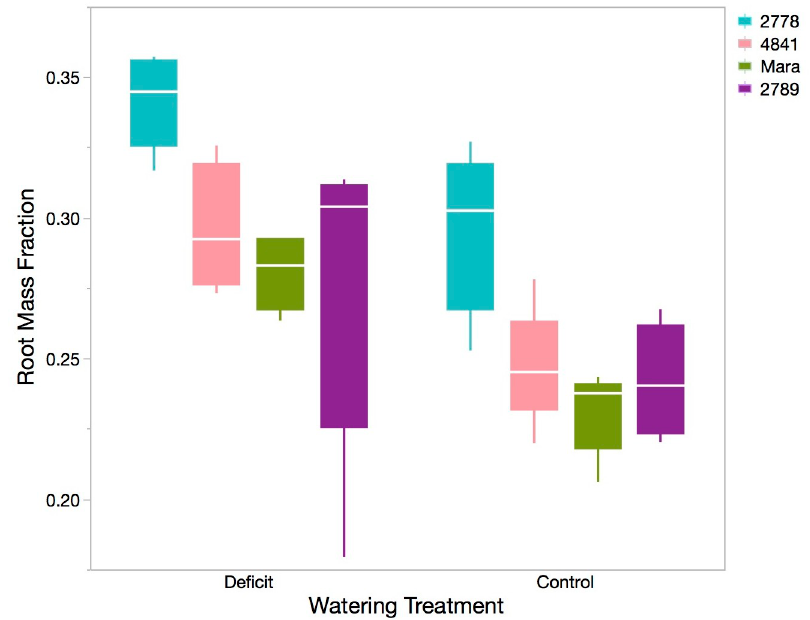
Fig 2. Box plot of root mass fraction for each genotype in both the water stress and control treatments. The solid box contains the inner two quartiles, whereas whisker lines indicate 1.5 x IQR (3 rd quartile minus the 1 st quartile) from the box. The white horizontal line is the